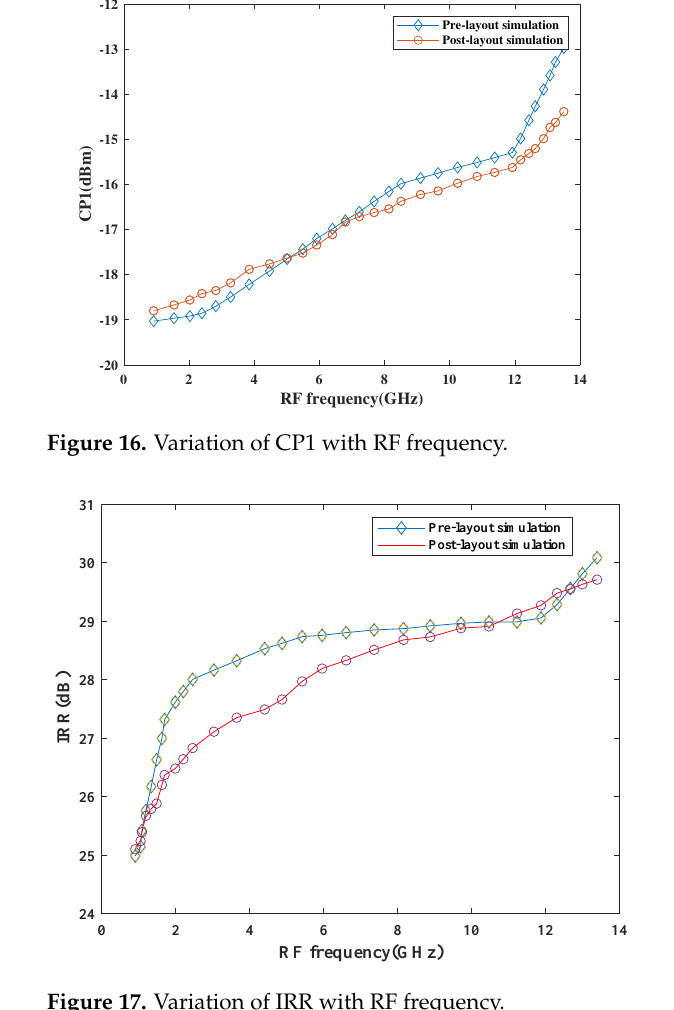
Figure 17. Variation of IRR with RF frequency.